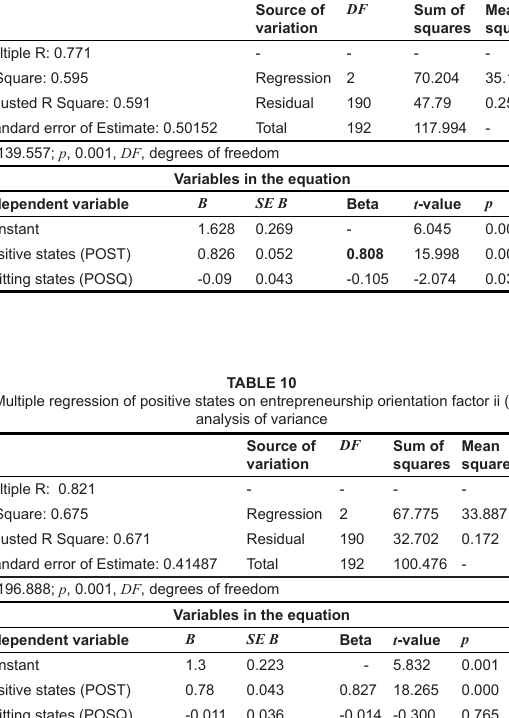
TABLE 9 analysis of variance DF Sum of Source of Mean variation squares square